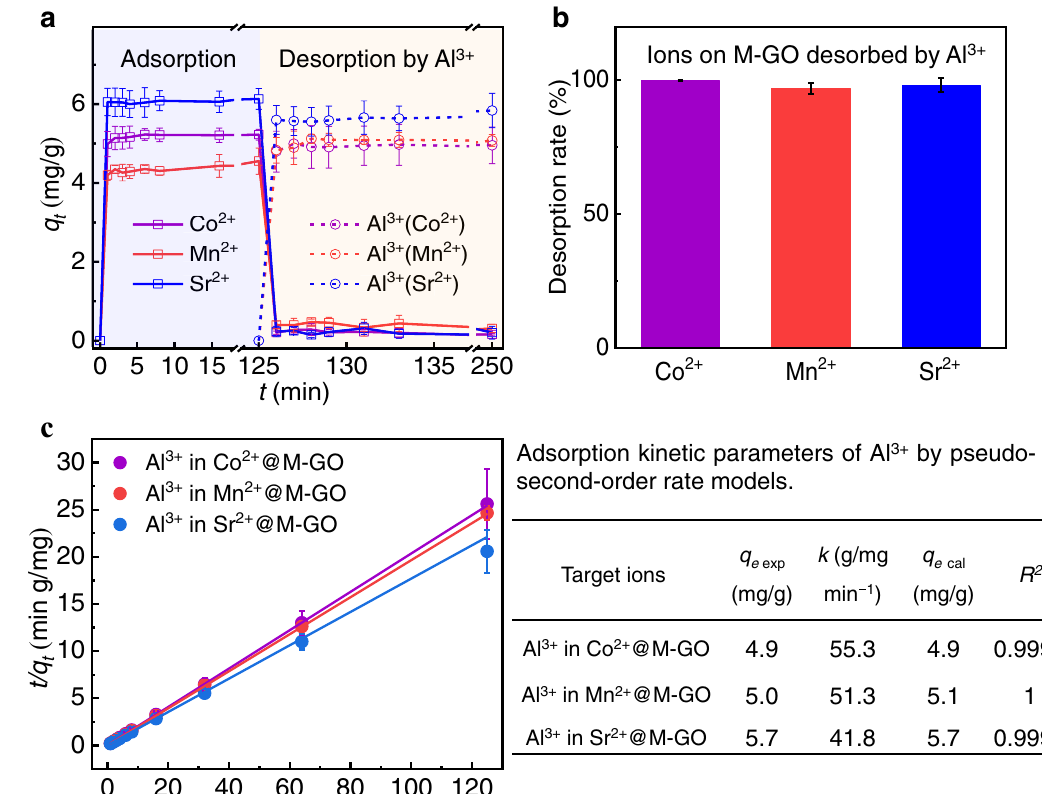
Fig.2|IonadsorptionanddesorptionofM-GO.a Adsorptionkineticsof10mg/L Co 2+ ,Mn 2+ ,andSr 2+ byM-GO,aswellasadsorptionkineticsof10mg/LAl 3+ addedto the salt solutions (Co 2+ , Mn 2+ , and Sr 2+ ) at 298K, respectively. q t denotes the adsorption capacity of M-GO with time. Light purple and light orange are high- lighted to distinguish between adsorption and desorption. b Desorption rate of